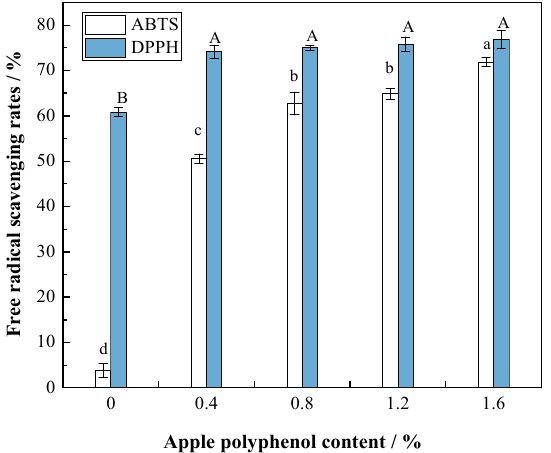
Figure 1. Effect of apple polyphenol addition on the free radical scavenging rates (%) of 2,2-di(4- tert -octylphenyl)-1-picrylhydrazyl (DPPH) and 2,2 ′ -azinobis-(3-ethylbenzothiazoline-6-sulfonic acid) (ABTS) in processed cheese. Different letters in the figure indicate significant differences between values ( p < 0.05).